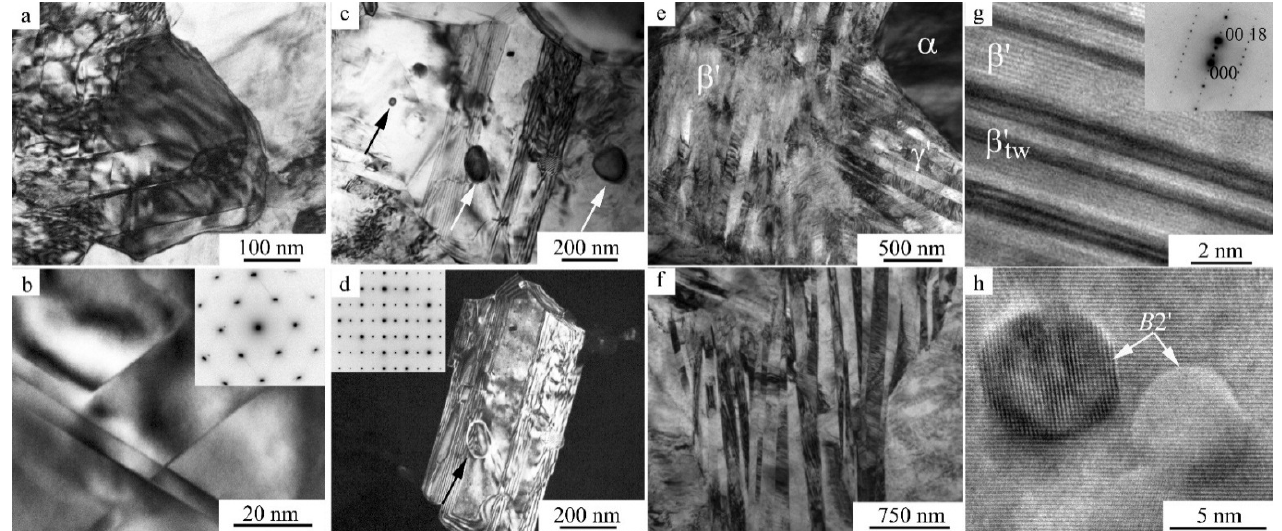
Figure 25. ( a , c , e , f ) Bright- and ( b , d ) dark-field TEM images (amplitude contrast) and ( g , h ) high- resolution TEM images (phase contrast) of the microstructure of the ( a , b ) α , ( c , d ) γ 2 and B2 ′ phases, ( e – g ) martensites and (h) B2 ′ phase particles after compression tests at ( a – d ) 773 K and ( e , g ) 873 K, ( f ) 973 K, and (h) 673 K [51,53].